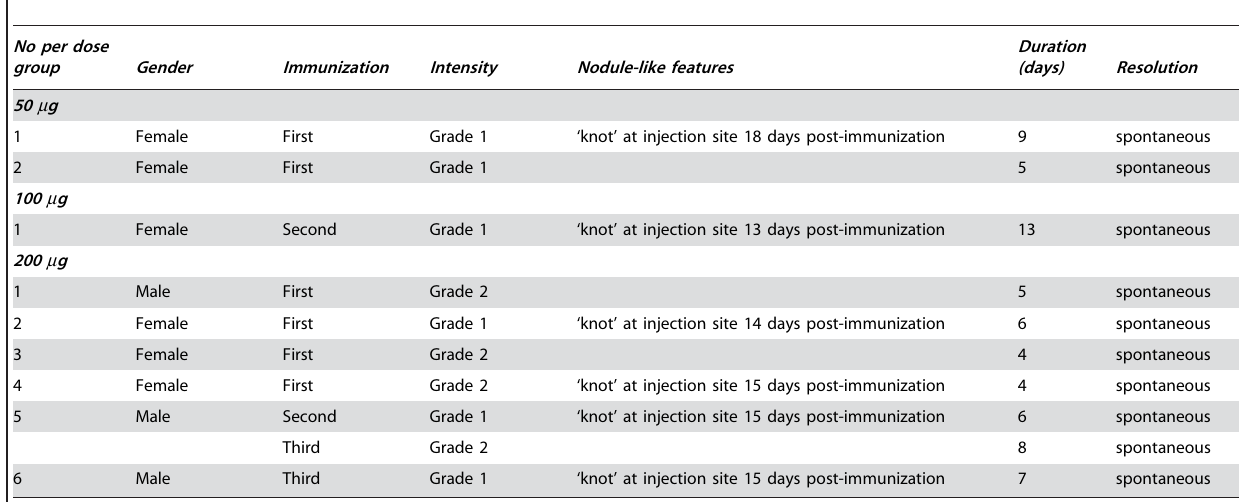
Table 4. Characteristics and evolution of induration* following immunization occurring in the study.